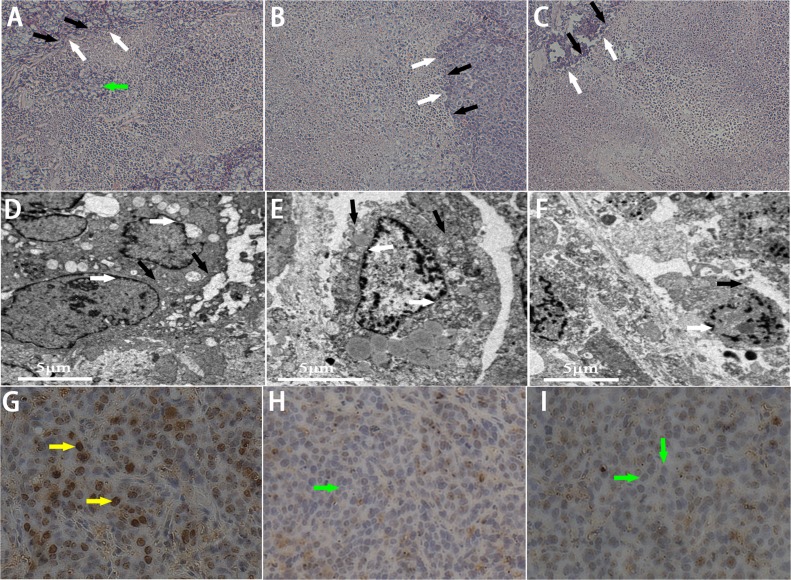
Pathological examination of the targeted area in rabbit breast tumor after HIFU ablation.(A, B, C) HE staining of the targeted area after HIFU ablation (200 × magnification). A sharp demarcation was showed between ablated (white arrow) and non-ablated (black arrow) region. The green arrow showed the residual tumor cells in the targeted area in PBS group. (D, E, F) TEM photos of the targeted tissue after HIFU ablation. Cell membranes (black arrow) and nucear membranes (white arrow) were interrupted and indefinable. (G, H, I) Expression of PCNA in tumor tissue after HIFU ablation (200 × magnification). The brown (yellow arrow) indicated PCNA-positive cells, the blue indicated PCNA-negative cells (green arrow). (A, D, G) HIFU + PBS; (B, E, H) HIFU + SonoVue MBs; (C, F, I) HIFU + NBs.